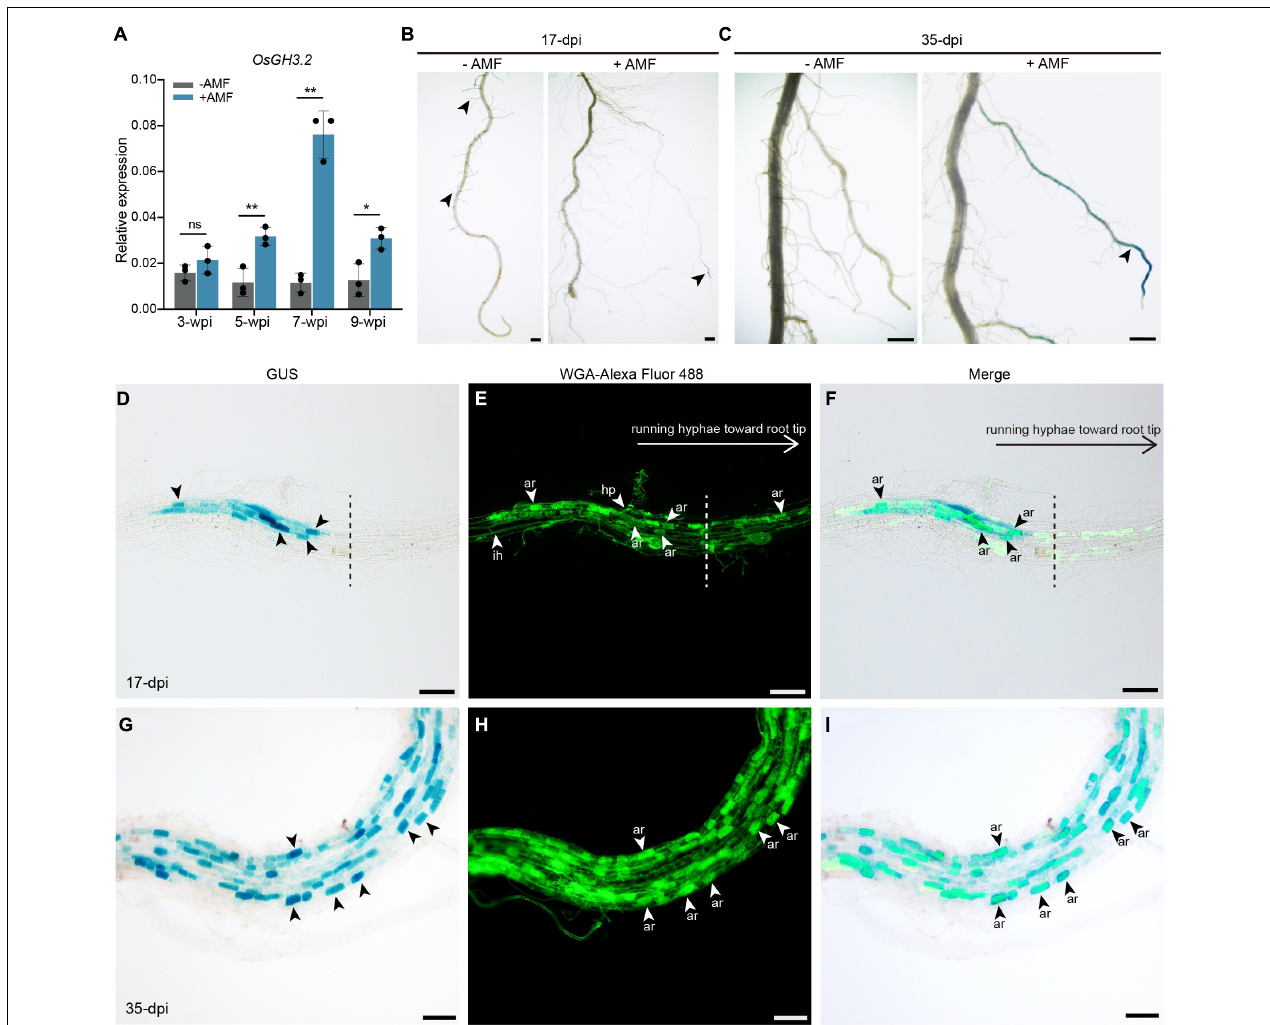
FIGURE 2 | Promoter activity of OsGH3.2 in mock-inoculated and R. irregularis -inoculated rice roots. (A) The relative expression levels of OsGH3.2 in wild-type rice roots were measured by qRT-PCR at 3-, 5-, 7-, and 9-wpi by R. irregularis . A housekeeping gene, OsUBI1 , was used for normalization. Data represent mean ± standard deviations (SD), n = 3. Statistical analysis was performed with Student’s t -test (ns, not significant; * p ≤ 0.05; ** P ≤ 0.01); (B) A representative crown root with GUS activity detected in many young lateral roots of mock inoculated (–AMF) roots and in a large lateral root of R. irregularis inoculated (+AMF) roots at 17-dpi; (C) after 35-days inoculation, a representative mock inoculated crown root showed no more GUS activity in mature LLR, while the GUS activity were shown in more mature LLRs of R. irregularis inoculated roots. The roots showed GUS activity were then counterstained with WGA-Alexa Fluor 488 to visualize fungal structures at 17- and 35-days post inoculation (dpi) by R. irregularis . (D–F) GUS activities were detected in cortical cells containing mature arbuscules below or near the hyphopodia; at the side of running hyphae toward root tip (separate with a dashed line), no GUS activities were detected in colonized cells. (G–I) After 35-dpi, GUS activities were detected in more mature arbuscules. Arrowheads indicate various of fungal structures: hp, hyphopodia; ih, intraradical hyphae; ar, arbuscules. The scale bars represent 1 mm (B,C) and 100 µ m (D–I)